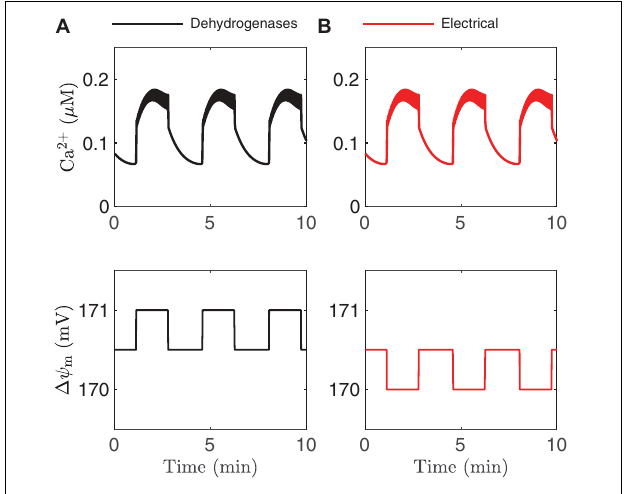
FIGURE 8 | Schematic of experimental findings on the mitochondrial membrane potential (cid:52) ψ m If the dehydrogenase effects prevail, (cid:52) ψ m hyperpolarizes during the active phase (A) , while (cid:52) ψ m depolarizes during the active phase if the electrical effect dominates (B) .